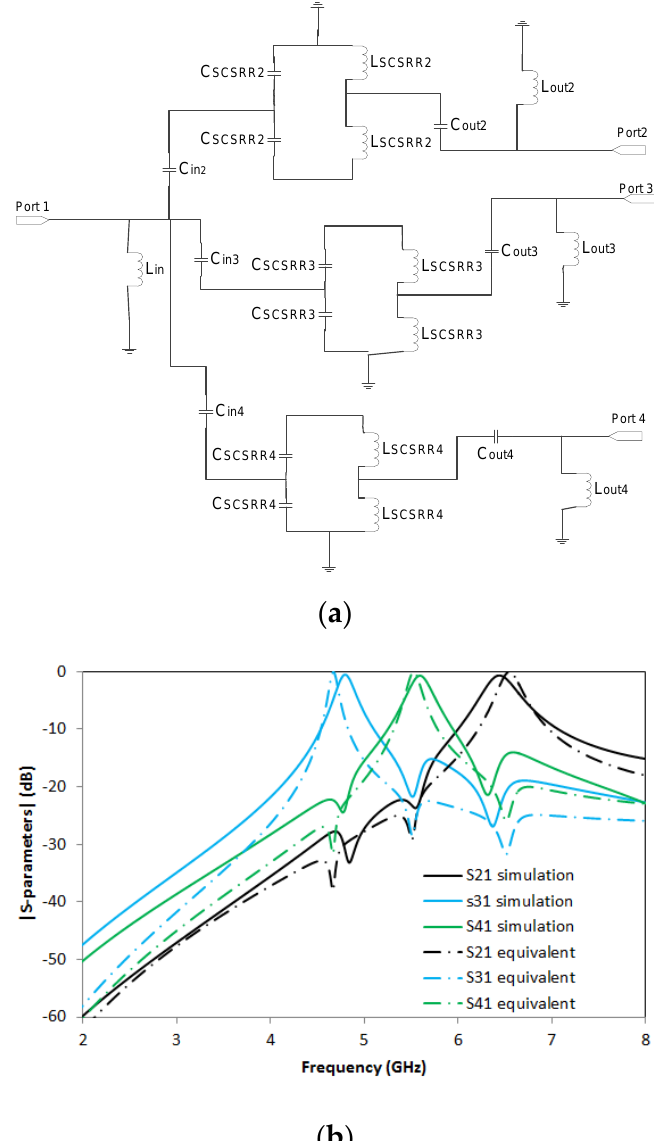
Figure 25. ( a ) Equivalent circuit of triplexer made with three SCSRR on ground plane. ( b ) Simulated S21 (dashed black line), equivalent circuit S21 (dashed-dotted black line), simulated S31 (dashed blue line), equivalent circuit S31 (dashed-dotted blue line), simulated S41 (dashed green line), and